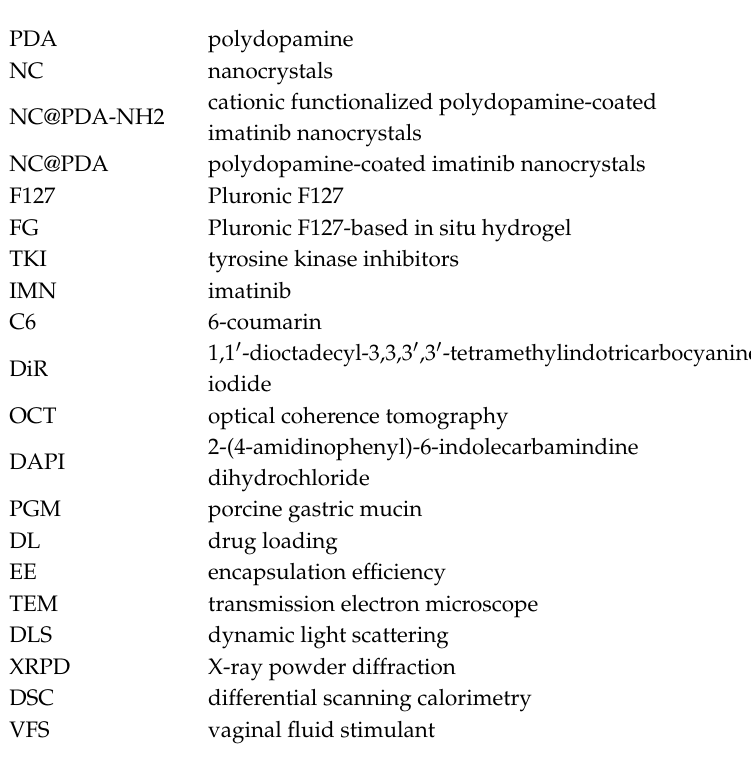
Figure S1: Influence of reaction time on the size distribution and zeta potential of resulted nanocrystals measured by dynamic light scattering. Left: reaction time of PDA@NC with Boc-NHCH 2 CH 2 NH 2 ; right: deprotection time in acidic environment, Figure S2: NC@PDA-NH2 with different zeta potentials for comparison of mucin adsorption, Figure S3: Size distribution and zeta potentials of C6-labeled NC, NC@PDA, and NC@PDA-NH2, Figure S4: Typical chromatograph for imatinib (1 ug/mL, LLOQ), Figure S5: Typical chromatograph of vaginal lavage samples after intravaginal administration of